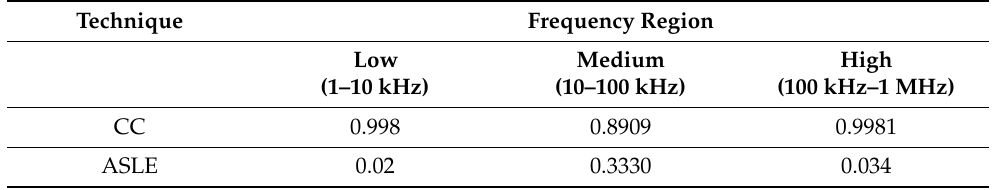
Figure 9. Frequency responses for a transformer faulty winding based on fingerprint comparison. Table 5. Numerical technique for fingerprint vs. after deformation.